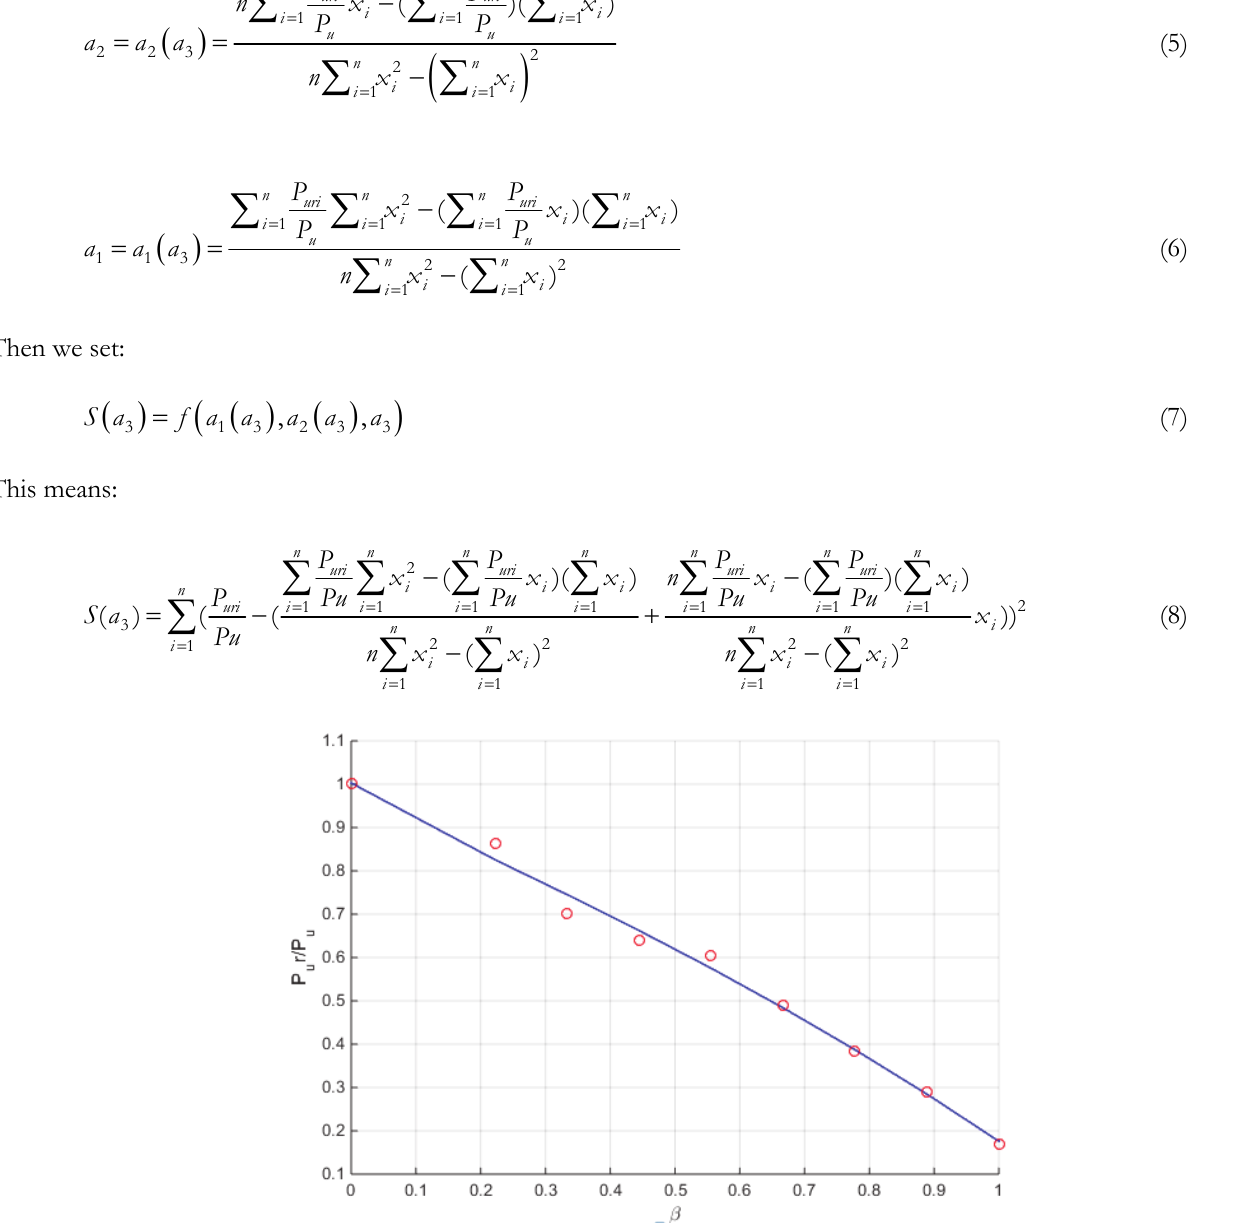
Figure 7: Dimensionless pressure loss as a function of fraction of